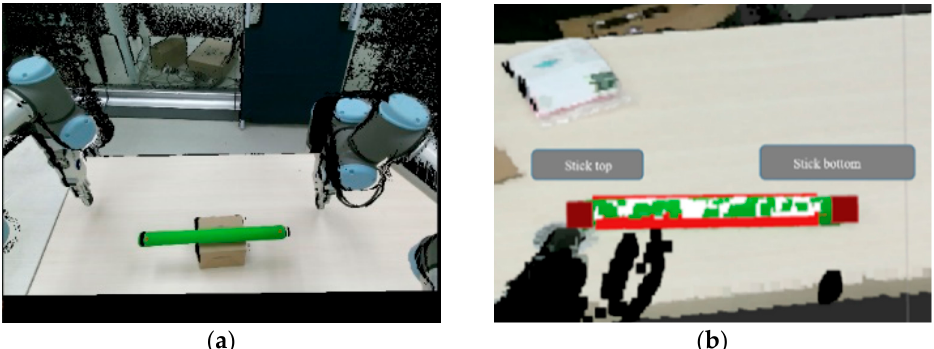
Figure 12. The ends of the thin rod in the robot’s view. The threshold of the color selected according to the pixel value of the thin green rod in the image. ( a ) The image obtained by the camera. ( b ) The recognition result of ends of the rod.